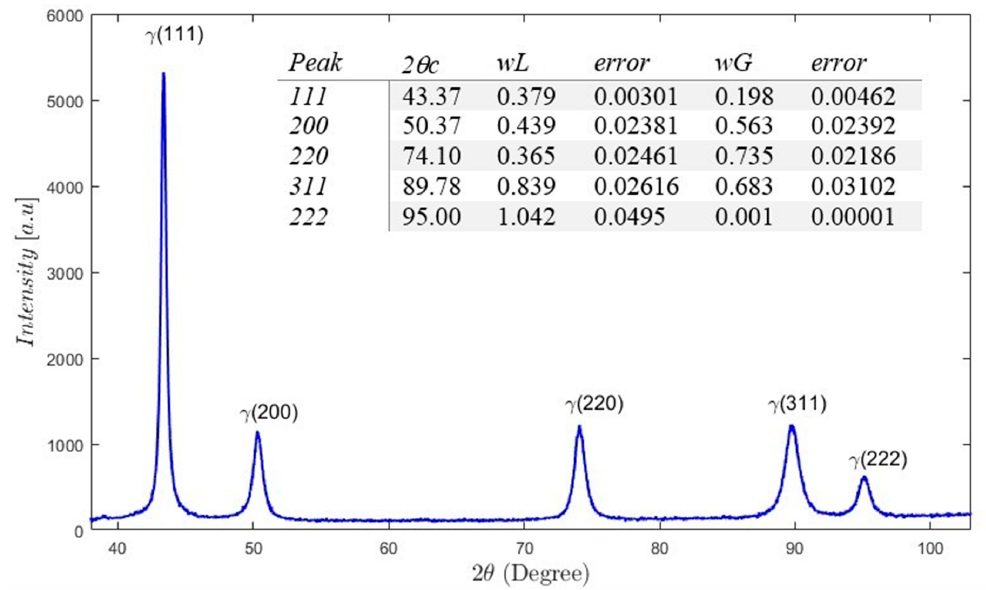
Figure 5. XRD for Hadfield commercial alloy. 2 θ c is the diffraction angle with maximum intensity. wL and wG are the Lorentzian and Gaussian breadth with respective errors. XRD extract from